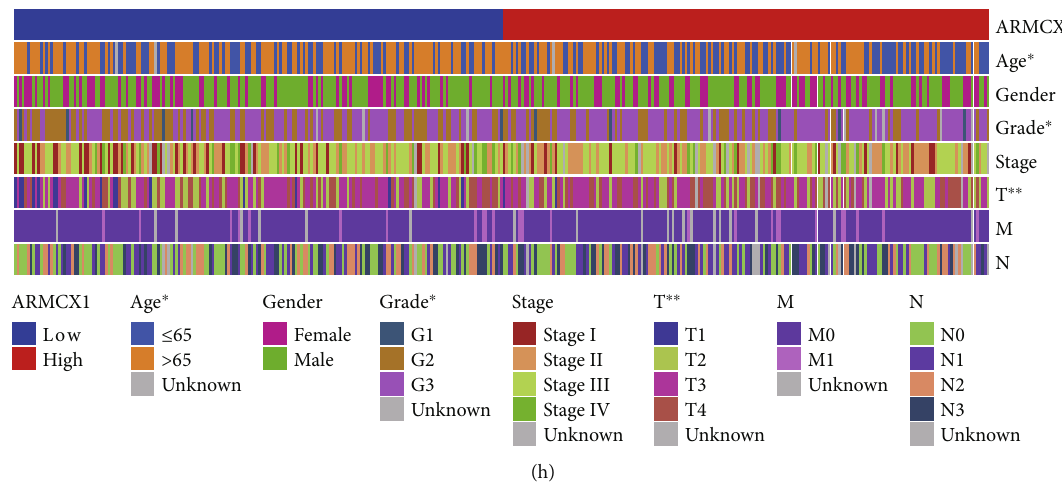
Figure 1: GC biopsies exhibited lower expression of ARMCX1 . (a) ARMCX1 expression in various cancerous tissues. (b, c) ARMCX1 expression in The Cancer Genome Atlas database compared with that in normal tissue. (d, e) Immunohistochemistry staining showed ARMCX1 protein in GC tissue. (f) Contour plots showed the expression of ARMCX1 in gastric cancer biopsies compared with paracarcinoma controls. (g) Statistical analysis of the expression level of ARMCX1 in gastric cancer biopsies compared with paracarcinoma controls. ∗∗ p < 0 : 01 . Each dot represents one readout. Nonparametric test. (h) Correlation between ARMCX1 and clinicopathological data of patients with